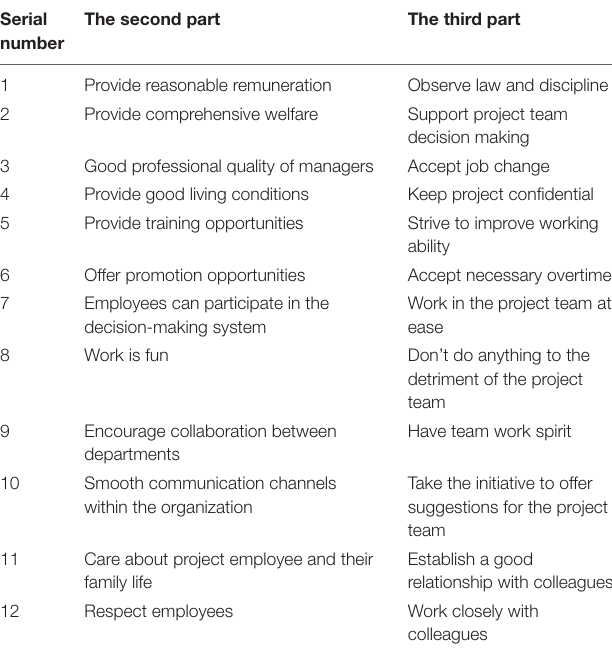
TABLE 1 | Question setting of the